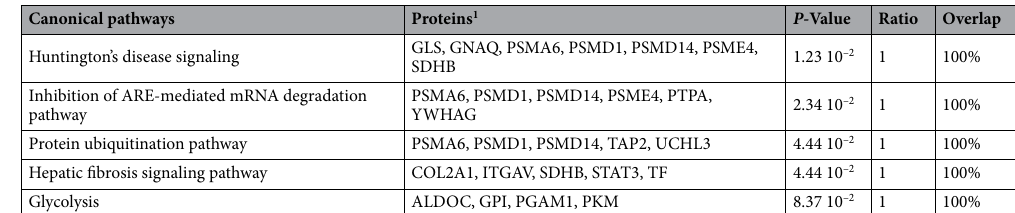
Table 4. Top canonical pathways enriched by observed protein alteration in BCO tibiae. 1 ALDOC, Aldolase, fructose-bisphosphate C; GLS, Glutaminase; GNAQ, G protein subunit alpha q; GPI, Glucose-6-phosphate isomerase; PGAM1, Phosphoglycerate mutase 1; PKM, Pyruvate kinase M1/2; PSMA, Proteasome 20S subunit alpha; PSMD, Proteasome 26S subunit, non-ATPase; PSME4, Proteasome activator subunit 4; PTPA, Protein phosphatase 2 phosphatase activator; SDHB, Succinate dehydrogenase complex iron sulfur subunit B; STAT3, Signal transducer and activator of transcription 3; TAP2, Transporter 2, ATP binding cassette subfamily B member; TF, Transferrin; UCHL3, Ubiquitin C-terminal hydrolase L3; YWHAG, Tyrosine 3-monooxygenase/ tryptophan 5-monooxygenase activation protein gamma.